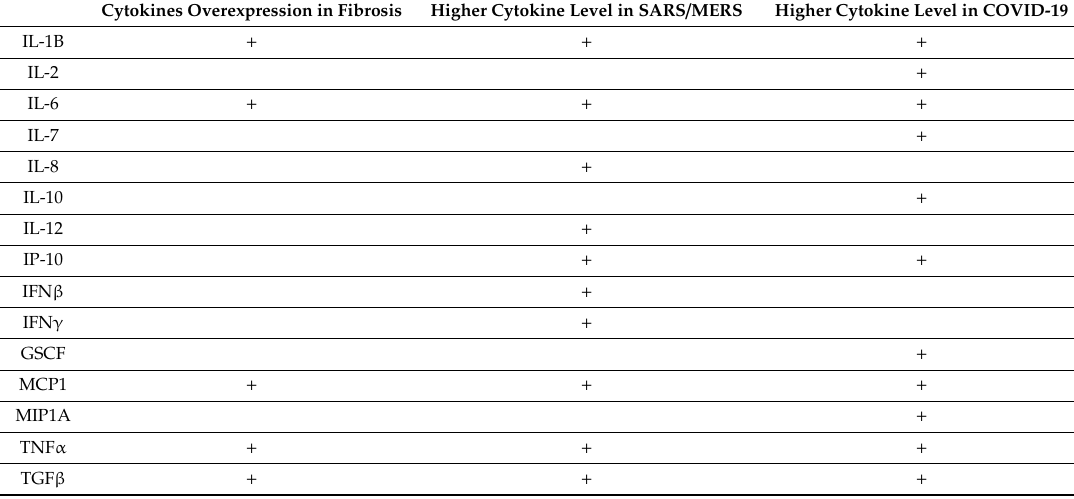
Table 2. Cytokines overexpression in fibrosis levels in COVID-19 and severe acute respiratory syndrome (SARS) / Middle East respiratory syndrome (MERS)